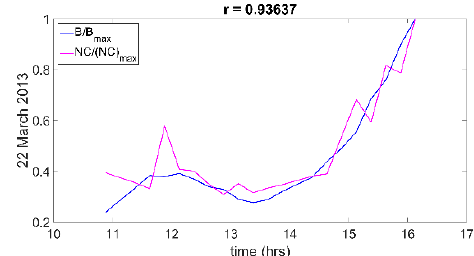
Figure 3. Hourly inter-comparisons of scattering coefficients under low relative humidity (RH < 20%) using the models’ NC/(NC) max and the instrumentation’s results (B/B max ) for 22 March 2013.